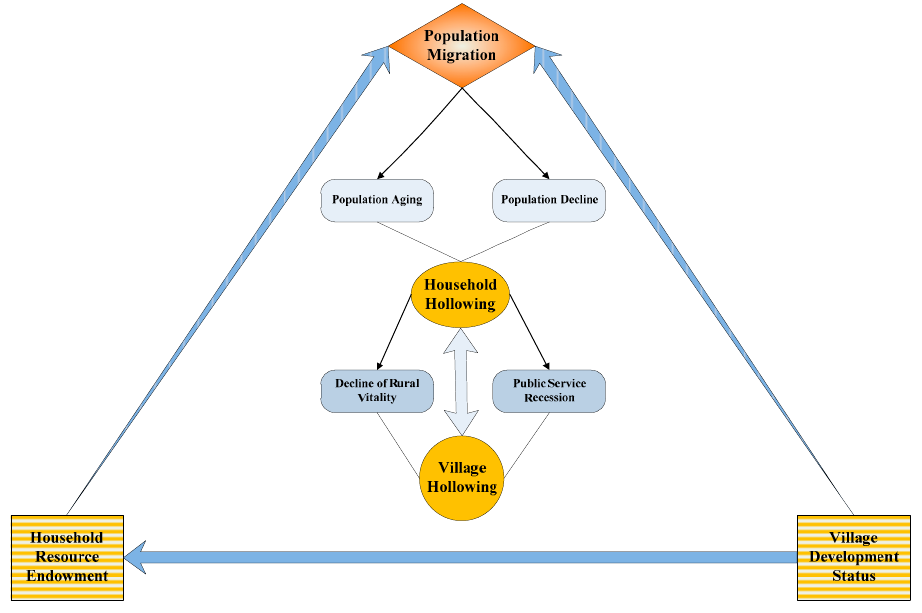
Figure 2. Logical framework of hollowing.